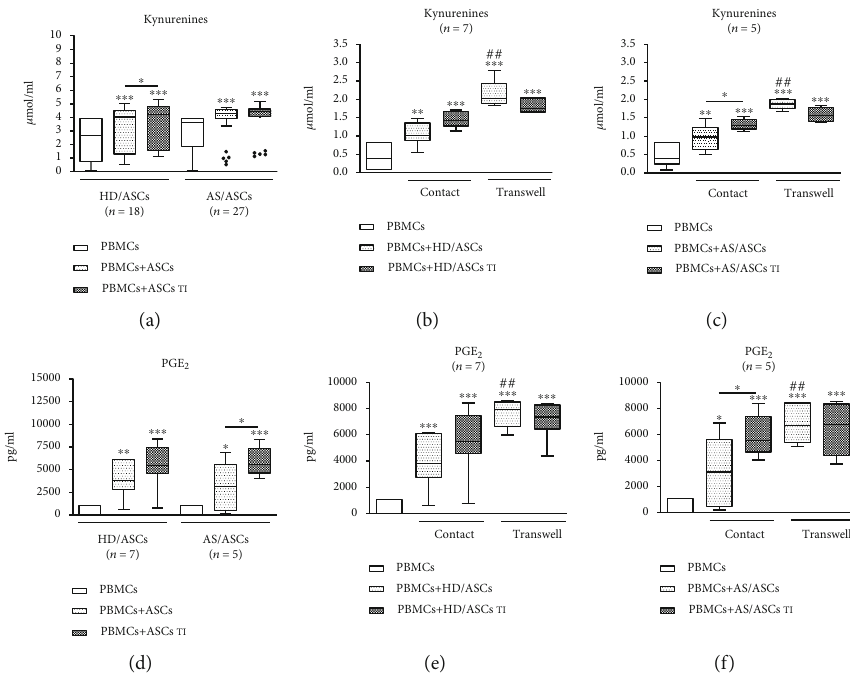
Figure 4: Upregulation of kynurenines and prostaglandin E (PGE ) synthesis in the contacting and noncontacting cocultures of PBMCs 2 2 with ASCs. Cells were prepared and cocultured as described in Figures 1(a) and 1(d) and Figures 2(b), 2(c), 2(e), and 2(f). PBMCs were isolated from peripheral blood of 11 (a) or 5-7 (b – e) healthy blood donors. Five HD/ASC lines and AS/ASCs obtained from 12 (a) or 5-7 (b – e) patients were used. The concentrations of kynurenines and PGE in culture supernatants were measured as described in Material 2 and Methods. Data are shown as the Tukey ’ s boxes; the number of performed experiments ( n ) is shown. ∗ P = 0 : 05 ‐ 0 : 01 , ∗∗ P = 0 : 01 ‐ 0 : 001 , and ∗∗∗ P = 0 : 001 ‐ 0 : 0001 for comparison of cell cocultures vs. control separate cultures and as indicated. ## P = 0 : 01 ‐ 0 : 001 and ### P = 0 : 001 ‐ 0 : 0001 for comparison of contact vs. transwell